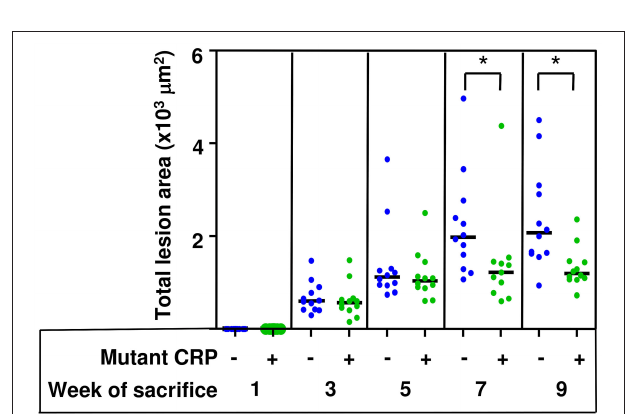
FIGURE 3 | Reduction in the size of atherosclerotic lesions in the aorta of mutant CRP-treated mice. The scatter plot shows the total atherosclerotic lesion area in en face aorta from untreated and mutant CRP-treated mice. Data were collected at five different time points: 1, 3, 5, 7, and 9 weeks after mutant CRP administration (12 mice per group per time point). Each blue dot represents one mouse from the untreated group and each green dot represents one mouse from the mutant CRP-treated group. Horizontal black lines indicate the median total lesion area for each group. Asterisks denote statistically significant difference between untreated and mutant CRP-treated groups (* p ≤ 0.01).